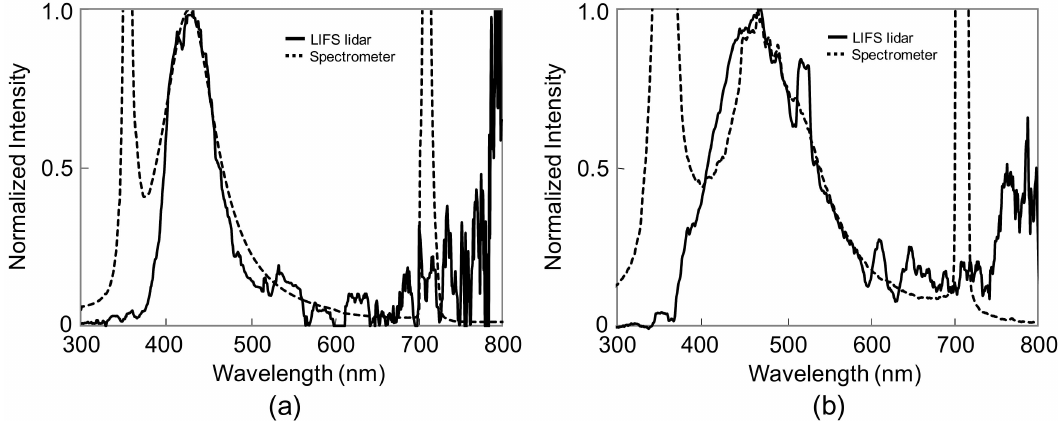
Figure 4. Flour fluorescence spectrum ( a ) and Jpn. red pine fluorescence spectrum ( b ) measured by the LIFS lidar.